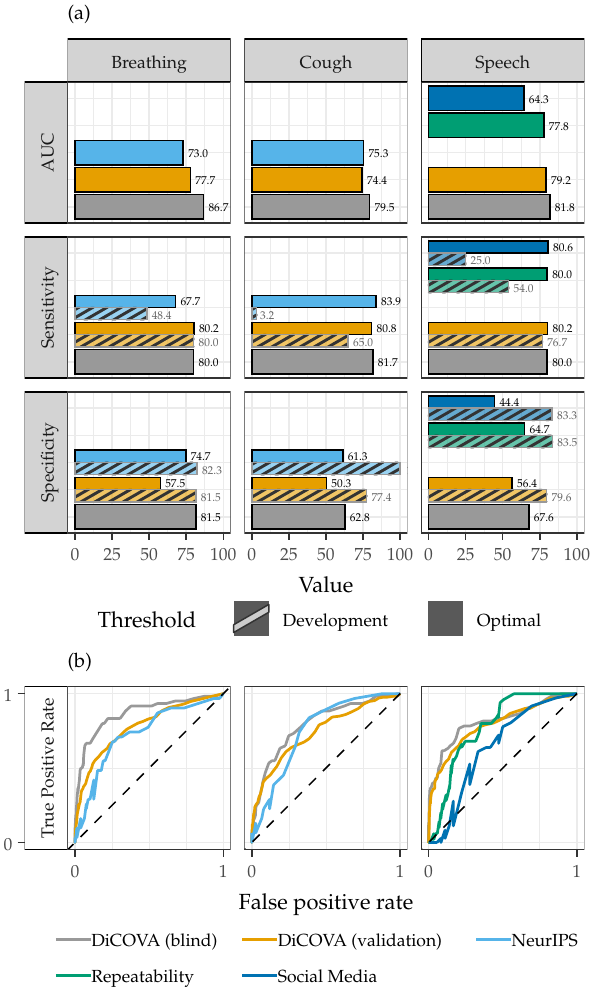
Figure 5. System ( a ) AUC-ROC, sensitivity, and specificity values and ( b ) ROC curves for breathing, cough, and speech sounds from all datasets classified individually.